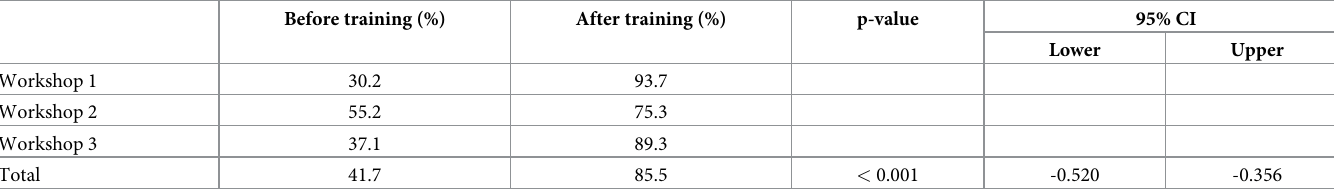
Table 1. Comparison of knowledge assessment results before and after training workshop